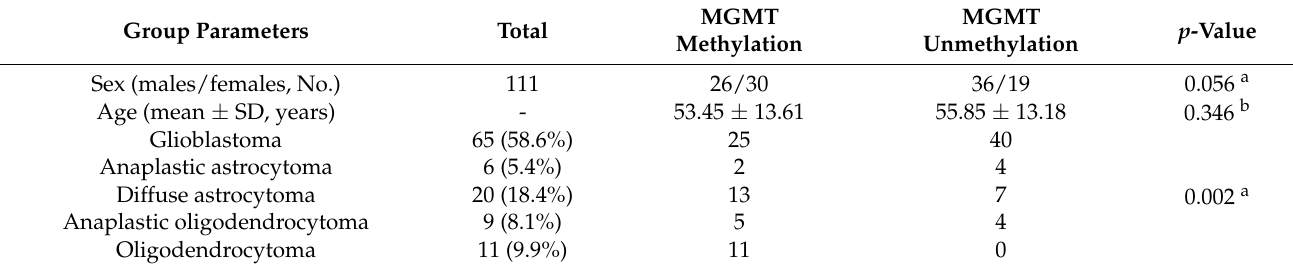
Table 1. Characteristics of the two